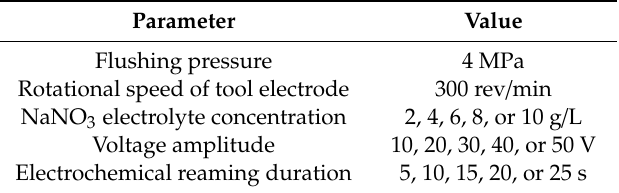
Table 3. Experimental parameters of the electrochemical reaming process.